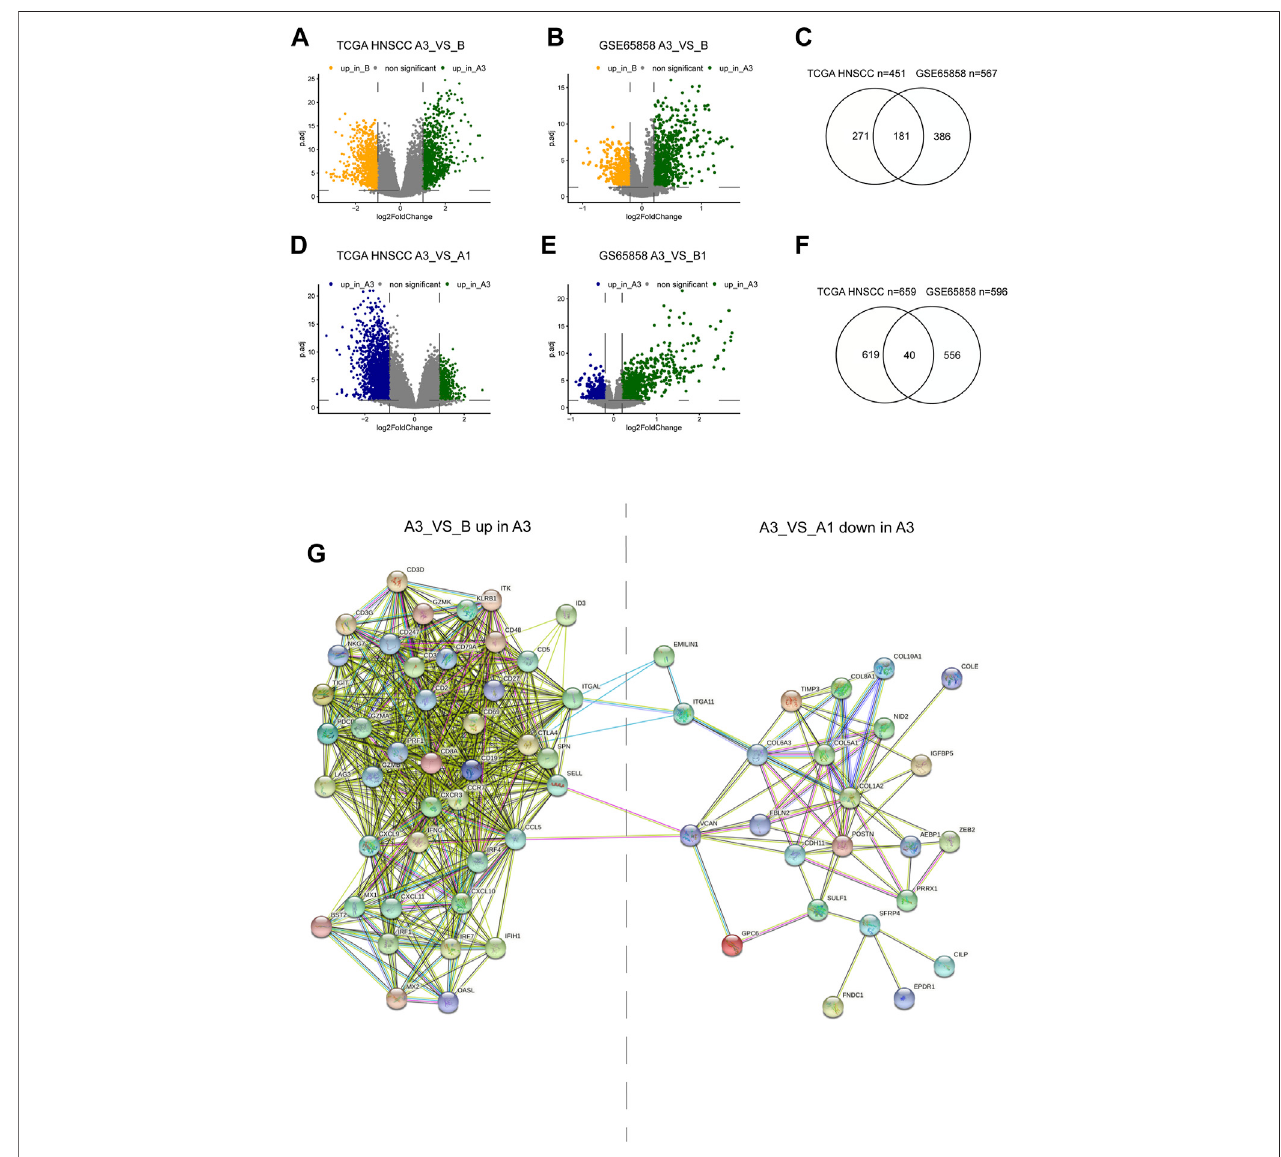
FIGURE4| Differentialgenesbetween subtypes and protein regulatorynetwork. (A,B,C) Volcano plot and Venn diagram show DEGsofA3vs Bin TCGA HNSCC and GSE65858 cohorts. (D,E,G) Volcano plot and Venn diagram showed the DEGs of A3 vs A1 in TCGA HNSCC and GSE65858 cohorts. (F) PPI protein regulatory network of 181 overlapping DEGs up in A3 (A3 vs (B) and the 40 overlapping DEGs down in A3 (A3 vs